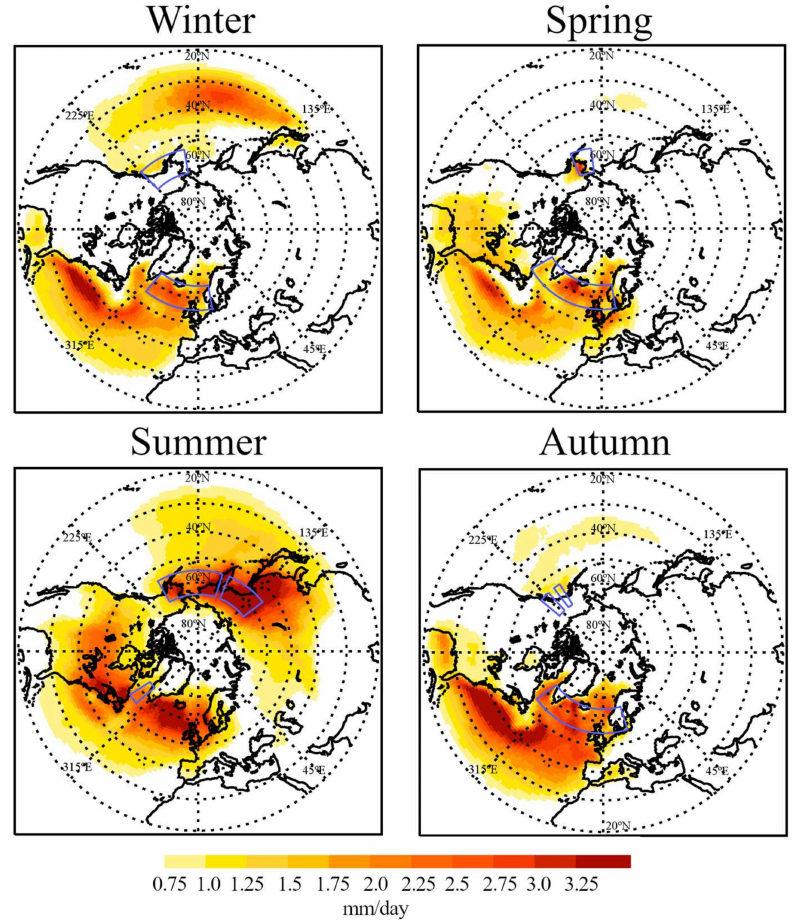
Figure 2. Climatological moisture sources ( ( E − P ) CLIM > 0 regions) throughout the period 1997–2014 for the regions of maximum AR occurrence represented by blue boxes. Scale in